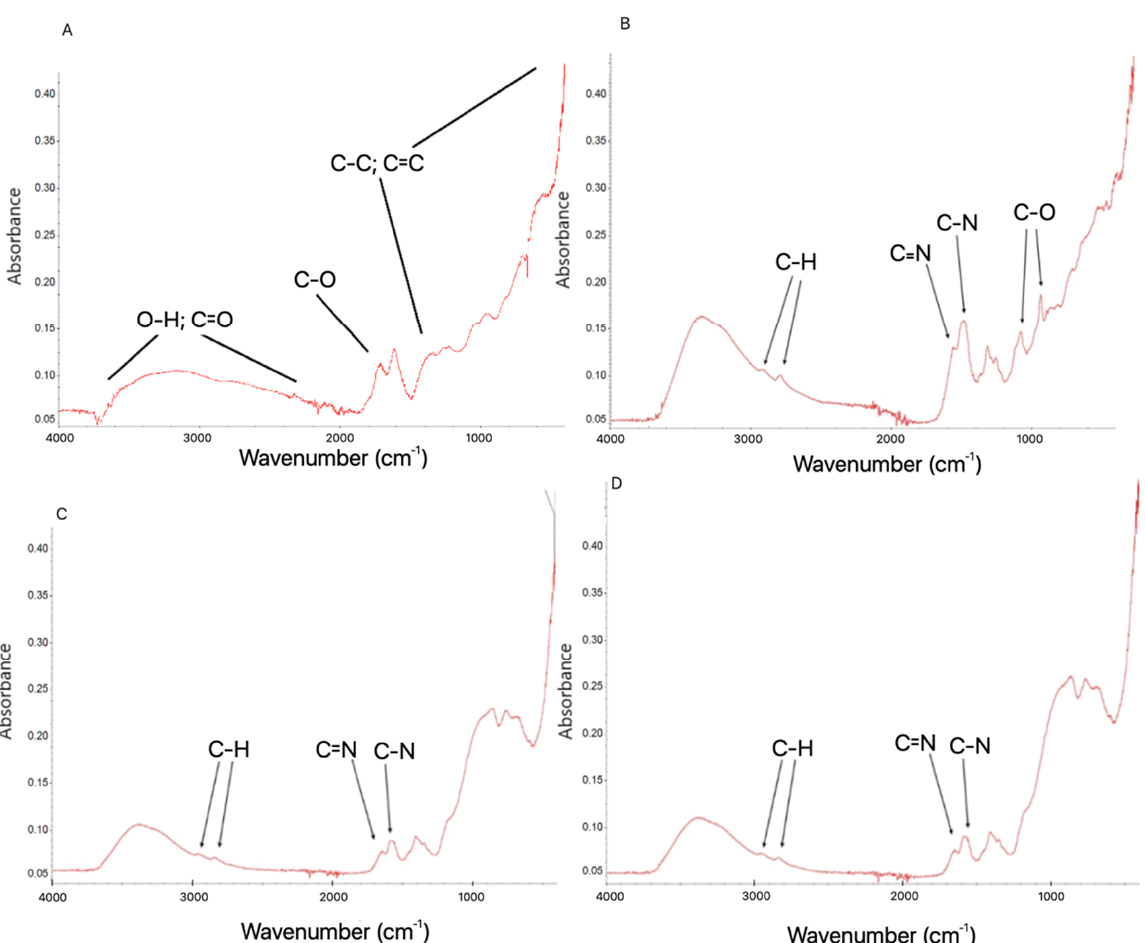
Figure 3. Fourier transform infrared spectrum of graphene oxide ( A ), reduced graphene oxide ( C ) and complexes of graphene oxide + miRNA ( B ) and reduced graphene oxide + miRNA ( D ). Abbreviations: GO: graphene oxide, rGO: reduced graphene oxide, GO + miRNA: complexes of graphene oxide functionalised with miRNA, GO + miRNA: complexes of reduced graphene oxide functionalised with miRNA.